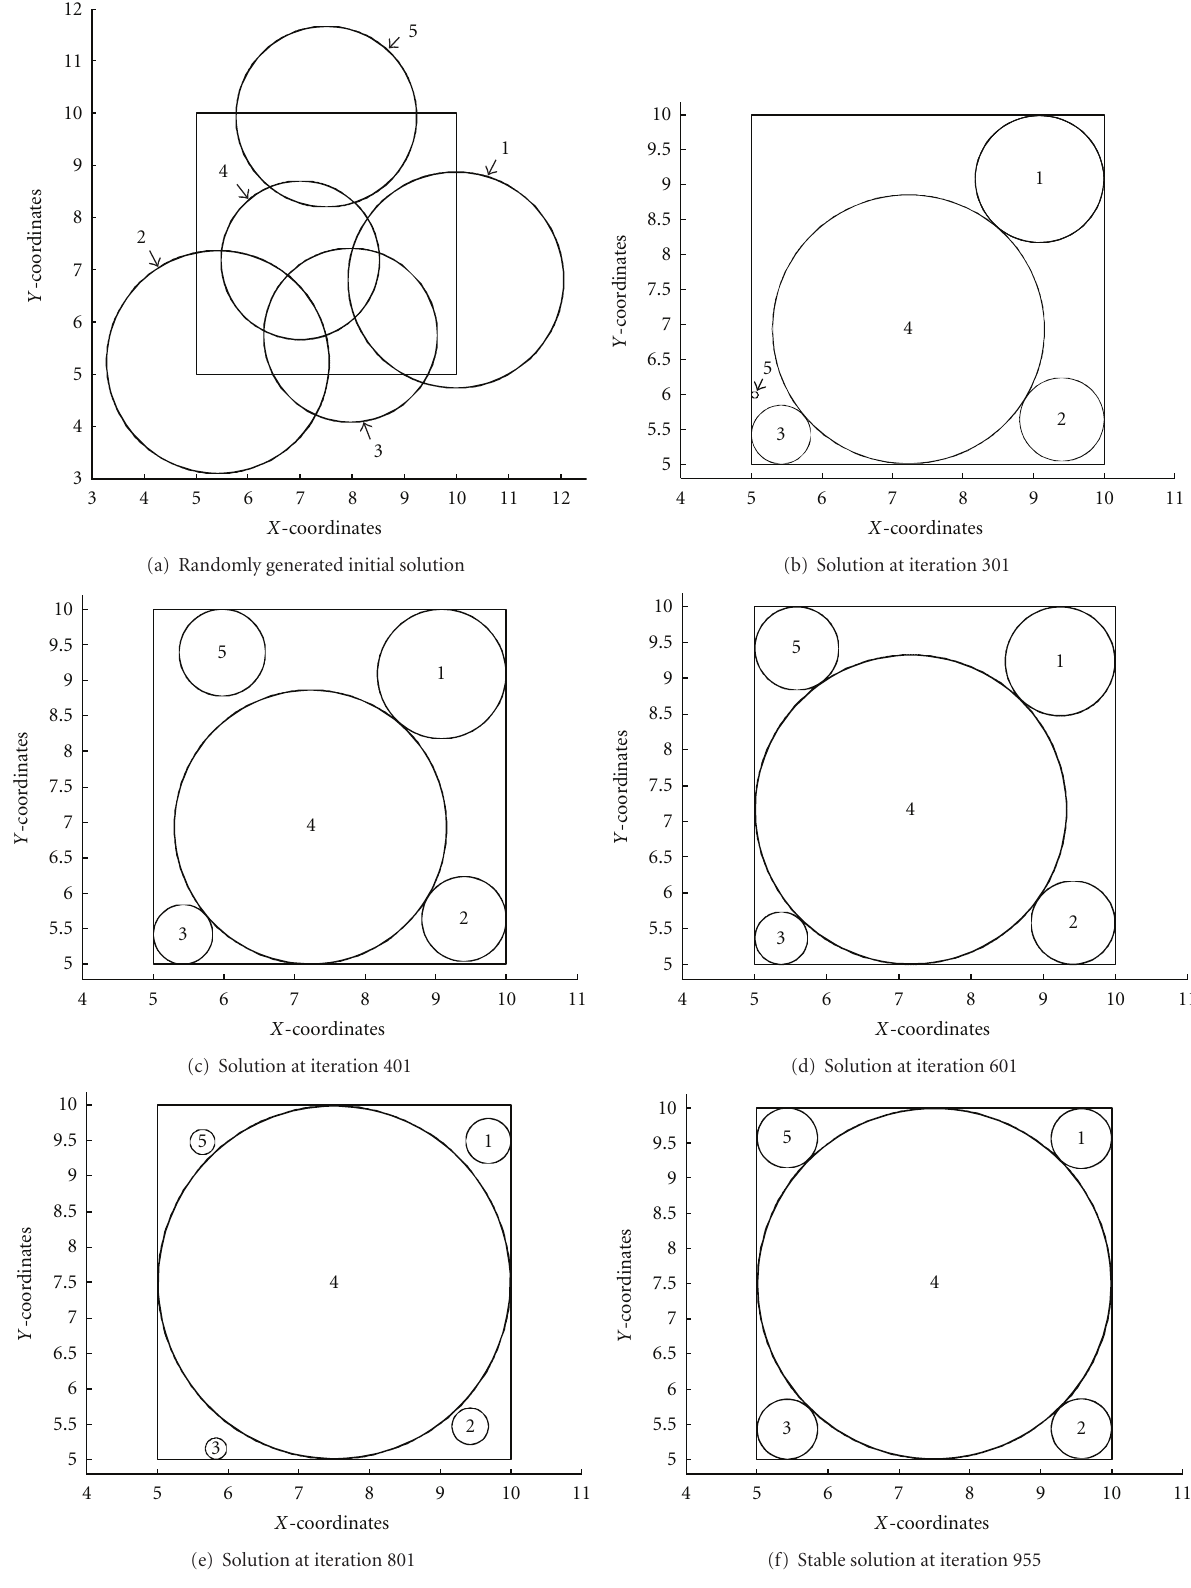
Figure 6: Stepwise solution for Case